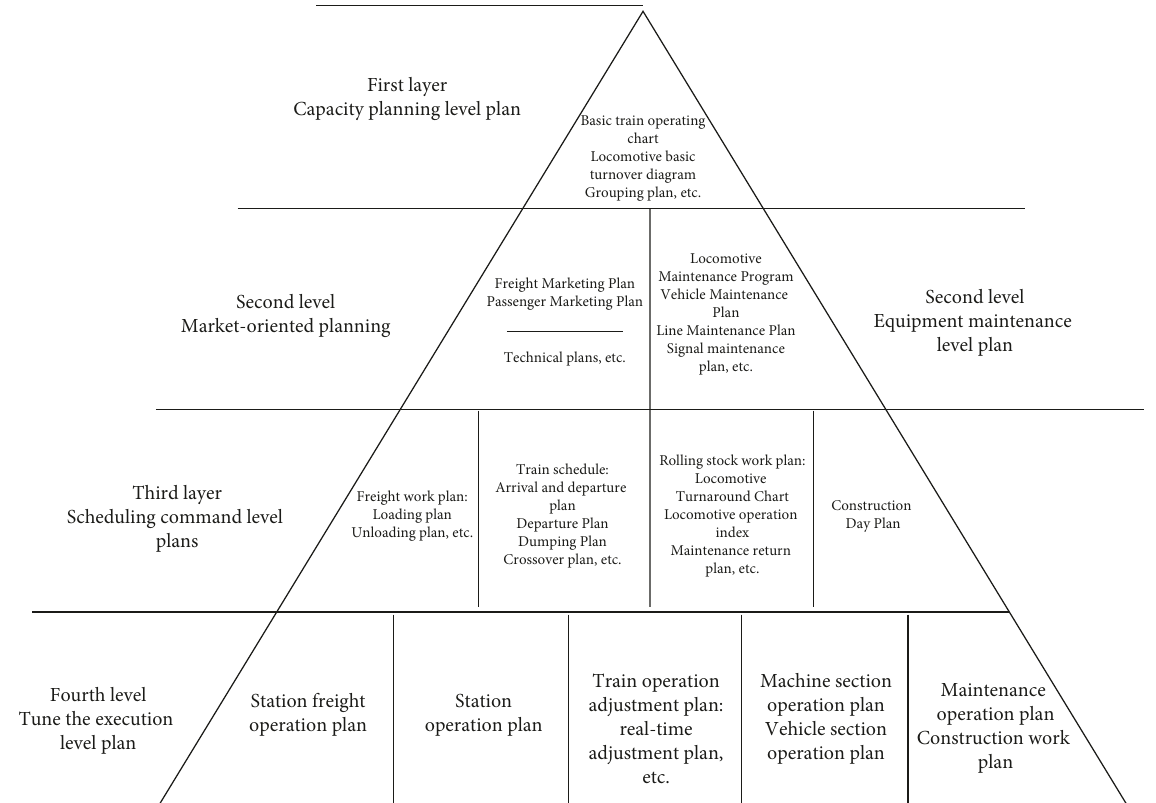
Figure 1: Four-level planning system of railroad